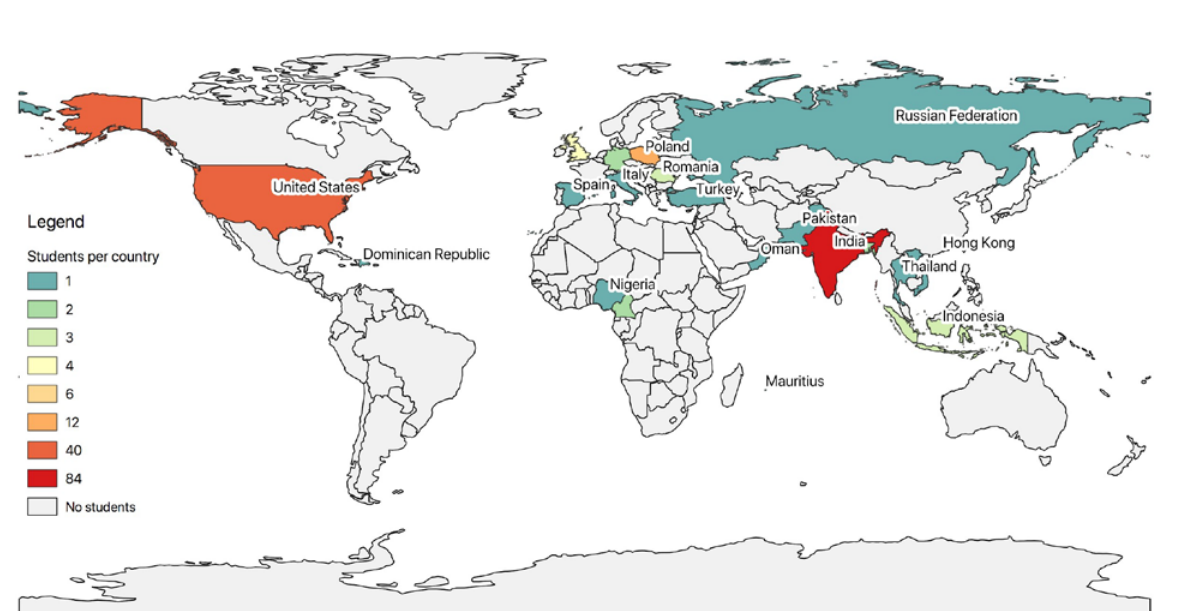
Figure 1. Overview of countries of origin of OSGeo students